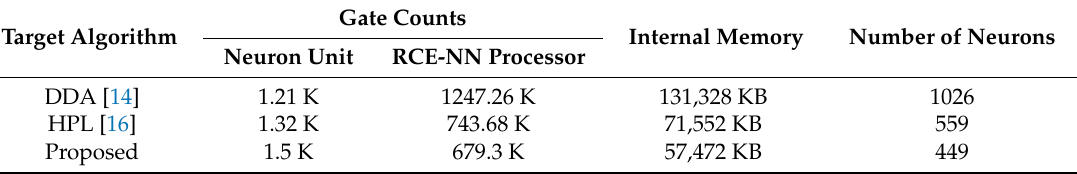
Table 3. Complexity comparison with existing RCE-NN